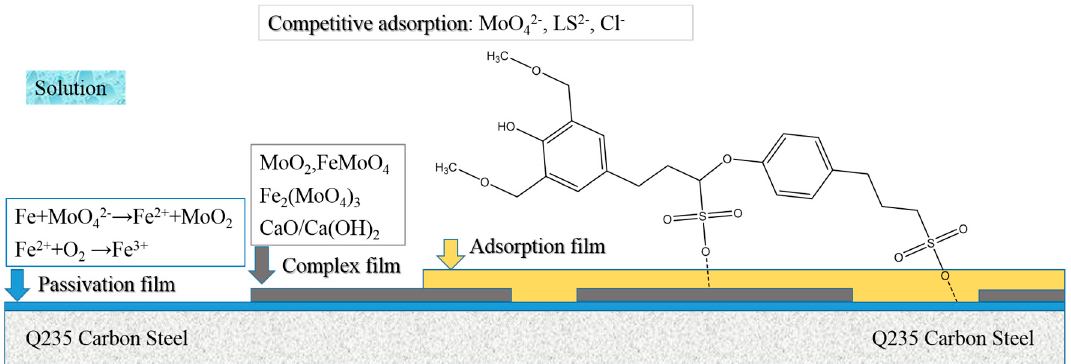
Figure 13. Illustration of the passivation-adsorption structure .